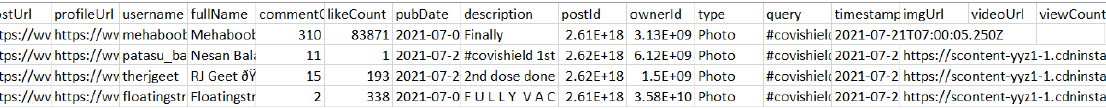
Figure 5. The #covishield post metadata with additional details such as the URL, likeCount, view- Count, and others.